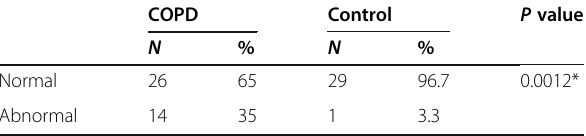
Table 7 Correlation between COPD severity and evoked potentials (visual and auditory)